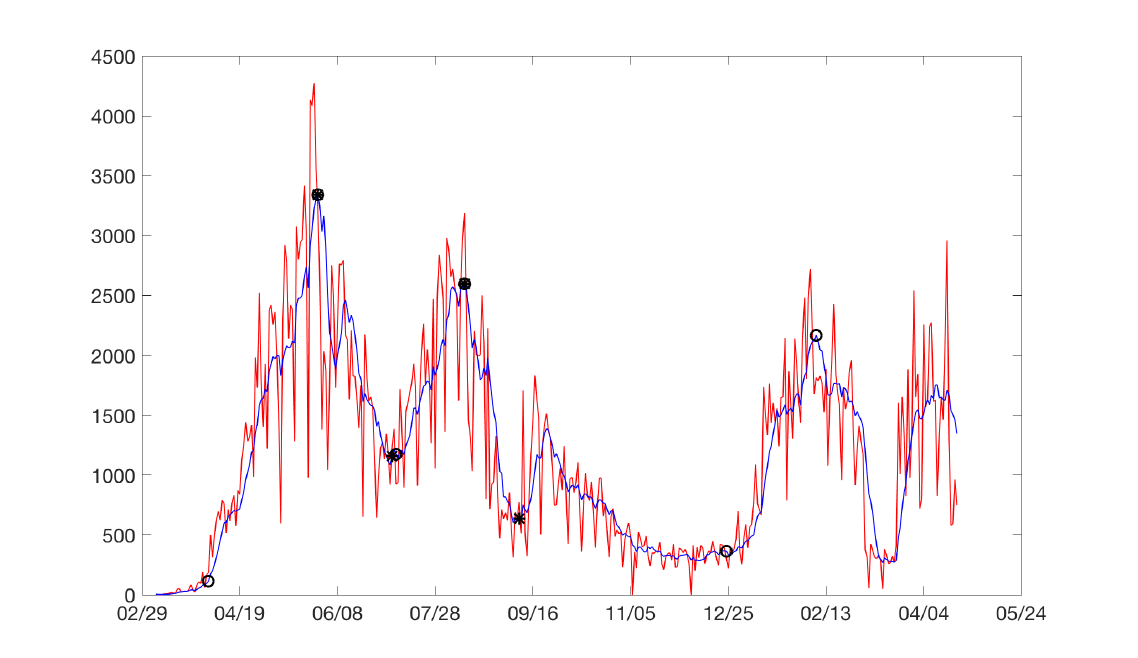
Figure A4. Lima: on the horizontal axis is the date in days and on the vertical axis are the daily